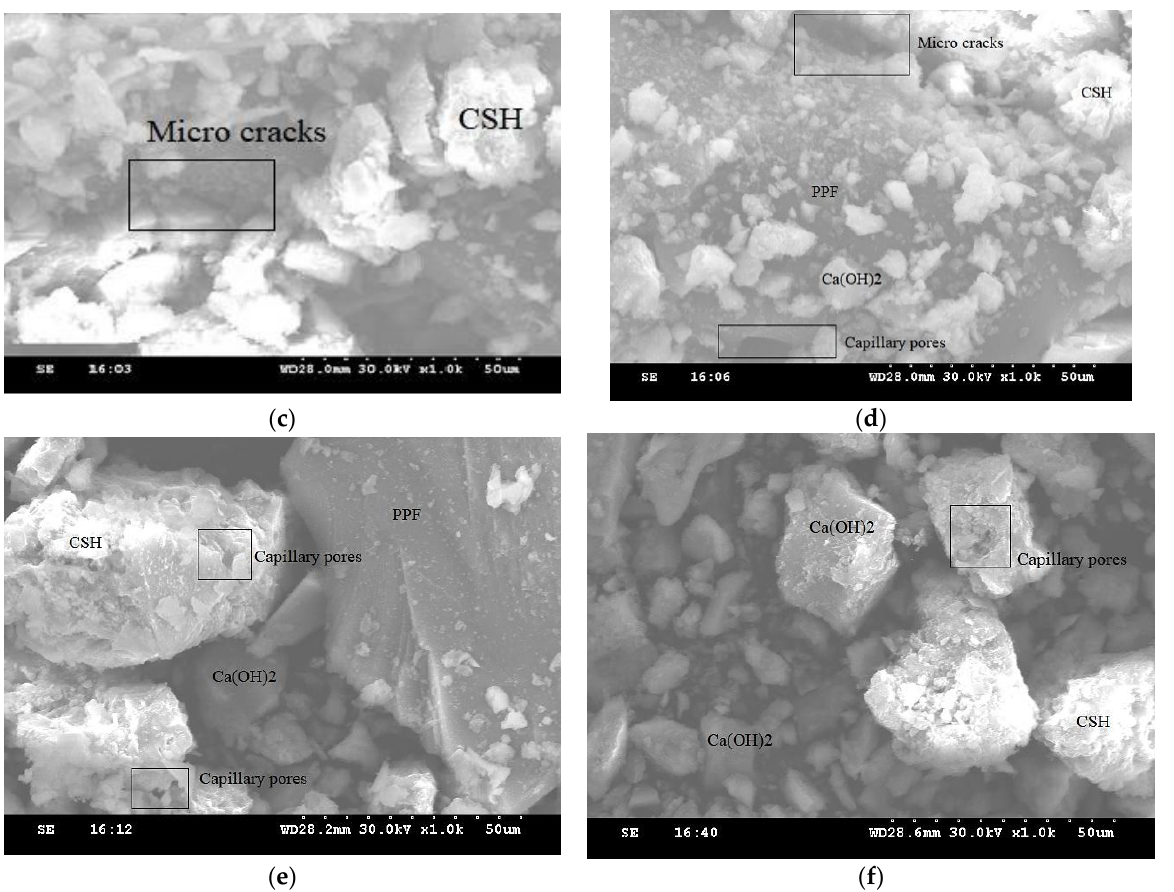
Figure 16. SEM images of CS–PPF concrete of CS20 group with 0.4% PPF. ( a ) CS0; ( b ) CS20; ( c ) CS40; ( d ) CS60; ( e ) CS80; ( f ) CS100.